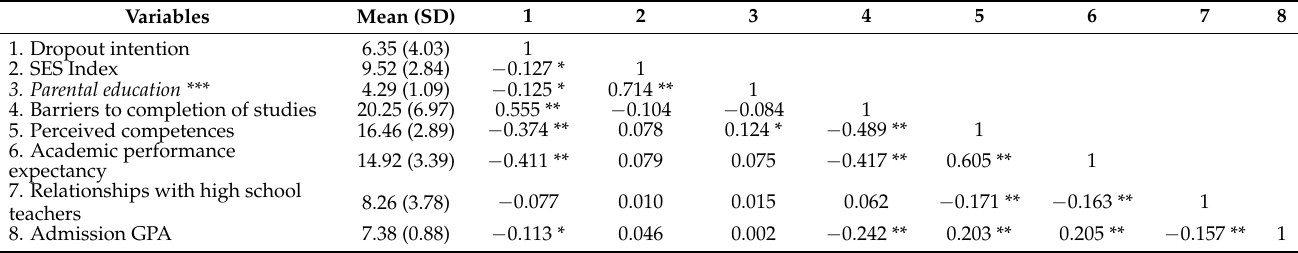
Table 1. Correlations between family socioeconomic status (SES Index) and dropout intention and other variables (H1). Variables